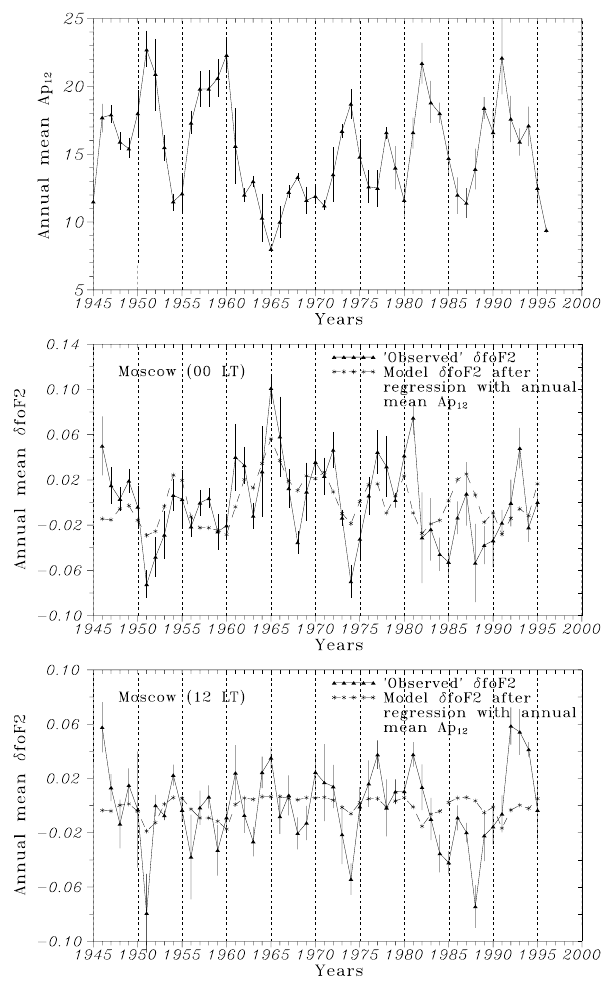
Fig. 10. Annual mean Ap 12 and δ fo F2 variations at Moscow, 00 and 12 LT. Dashed line is an attempt to remove the dependence on geomagnetic activity using δ fo F2 regression with Ap 12 . Note that observed δ fo F2 variations are much stronger than model ones especially for